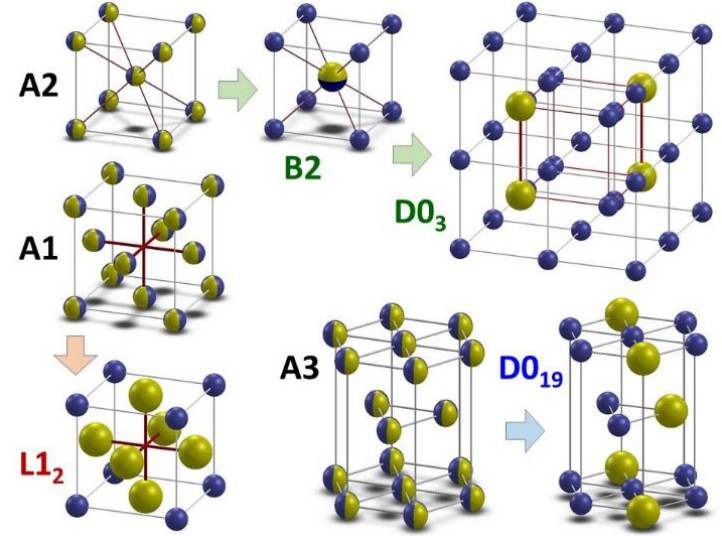
Figure 2. Typical disordered (A1, A2, and A3) and ordered (B2, D0 3 , L1 2 , and D0 19 ) phases in Fe–Ga alloys. Colors of balls correspond to composition Fe 3 Ga. alloys. Colors of balls correspond to composition Fe